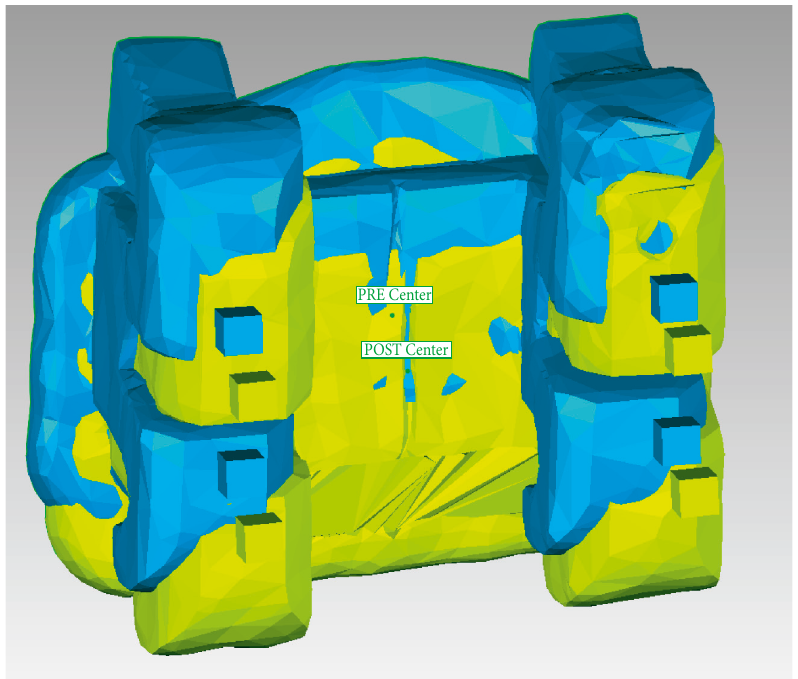
Figure 9: Superimposition of the precenter and postcenter coordinate systems.